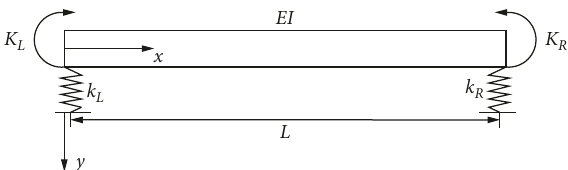
Figure 2: Elastic boundary conditions model of the